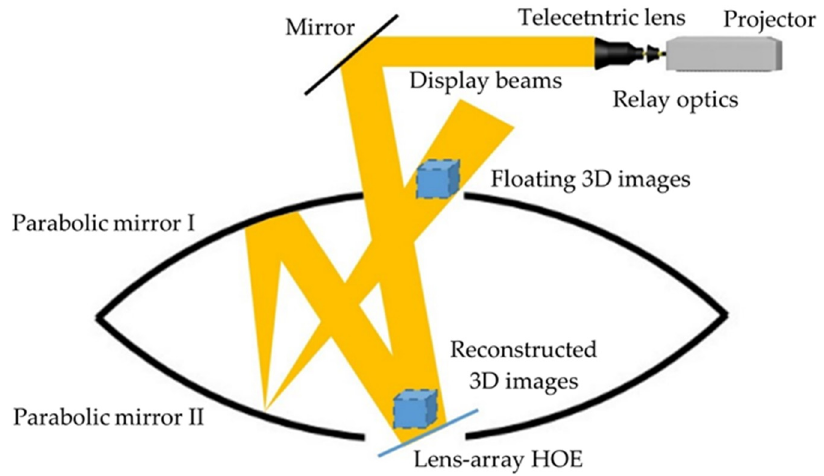
Figure 1. Principle diagram of the aerial projection 3D display based on a lens-array HOE and a pair of parabolic mirrors.